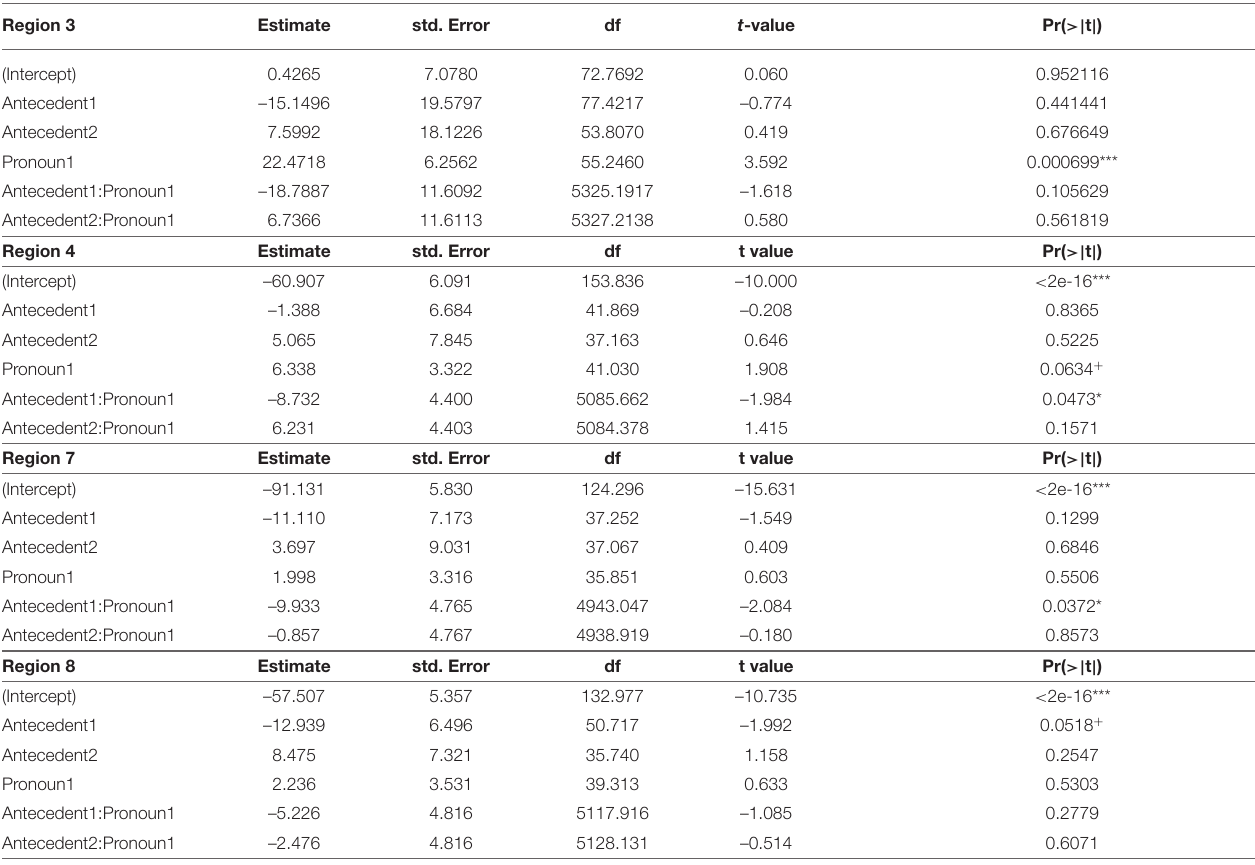
TABLE 8 | Fixed effects, Experiment 4, Regions 3, 4, 7, and 8. Region